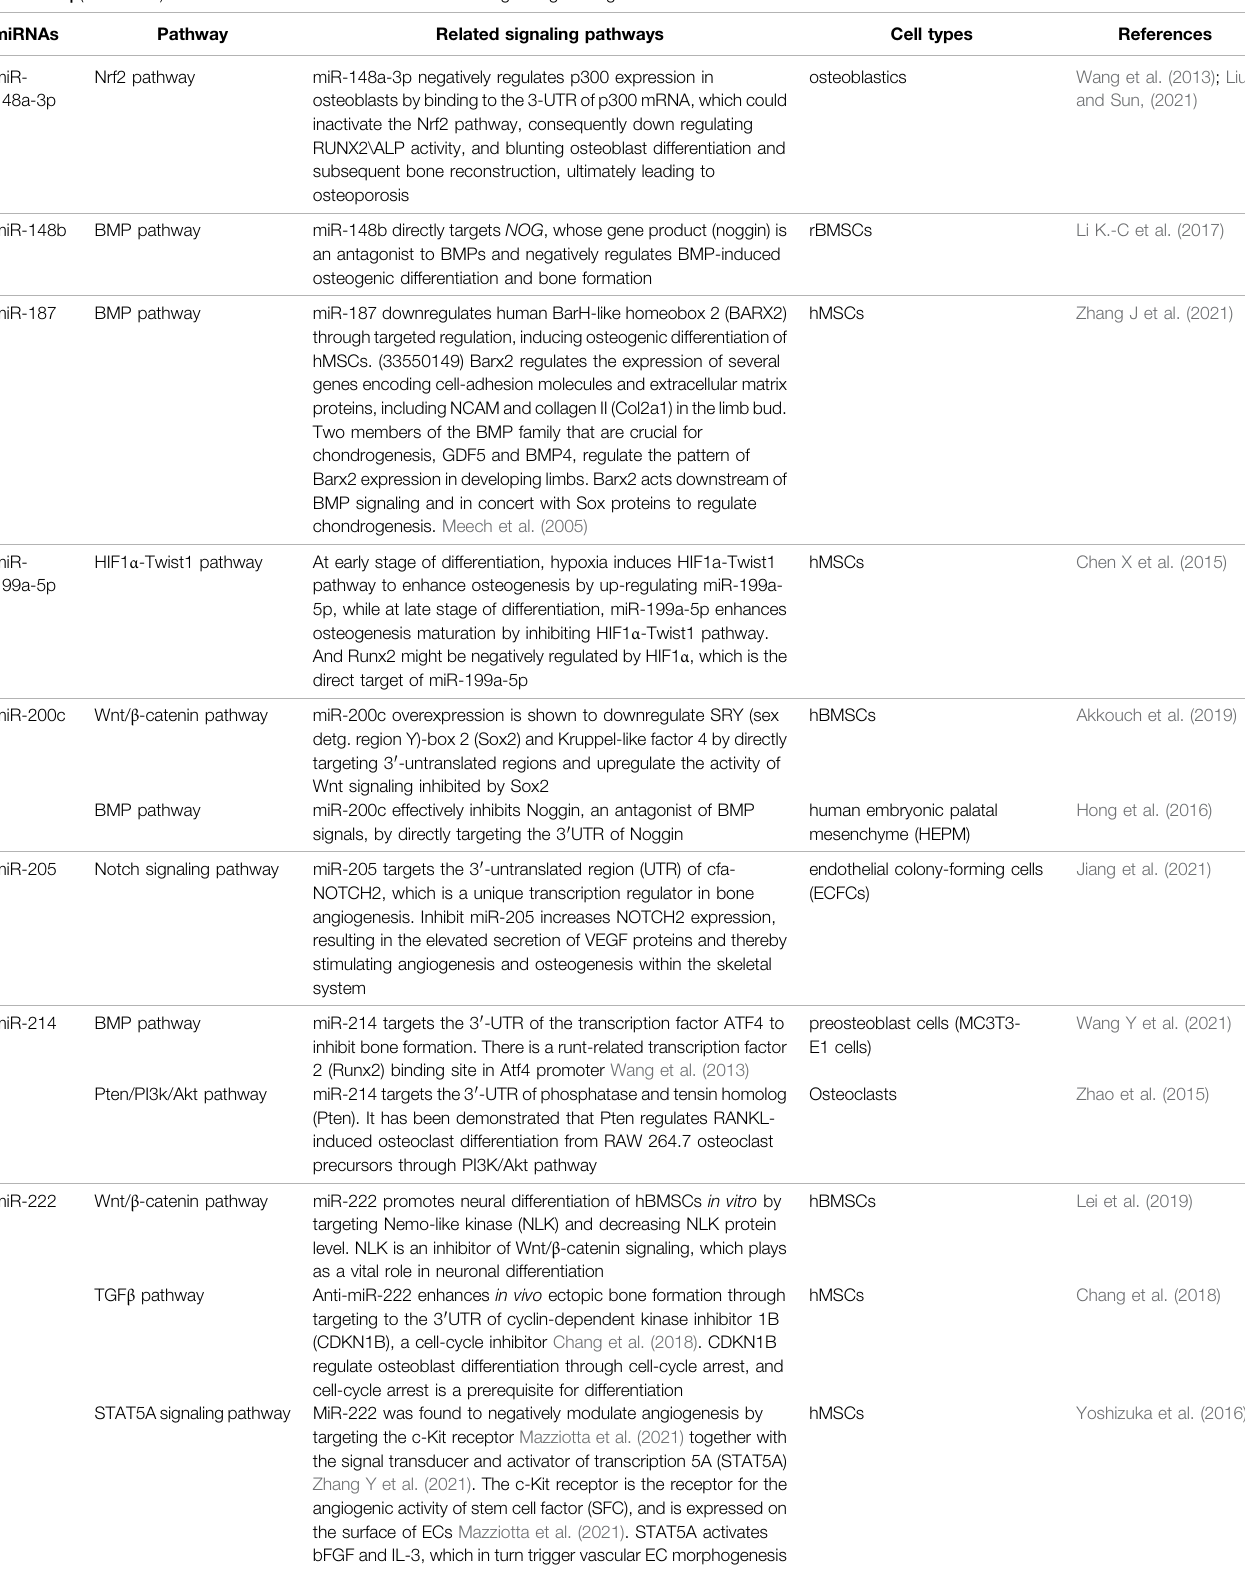
TABLE 2 | ( Continued ) The mechanism of miRNAs tested in vivo regulating osteogenic